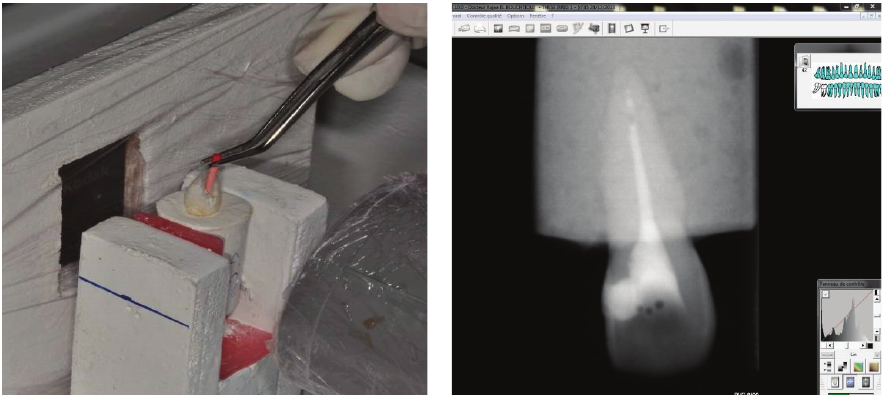
Figure 4: Active irrigation stirring of the cone and the corresponding